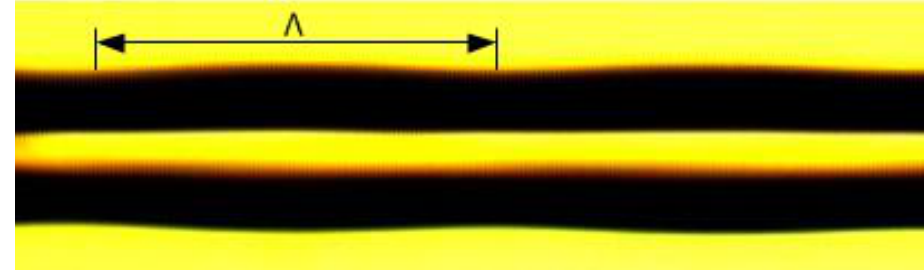
Figure 3. An optical micrograph of the deformation in the RHOF by the illumination of a CO laser. Such periodic deformations form the LPG, where Λ denotes the grating 2 periodicity.